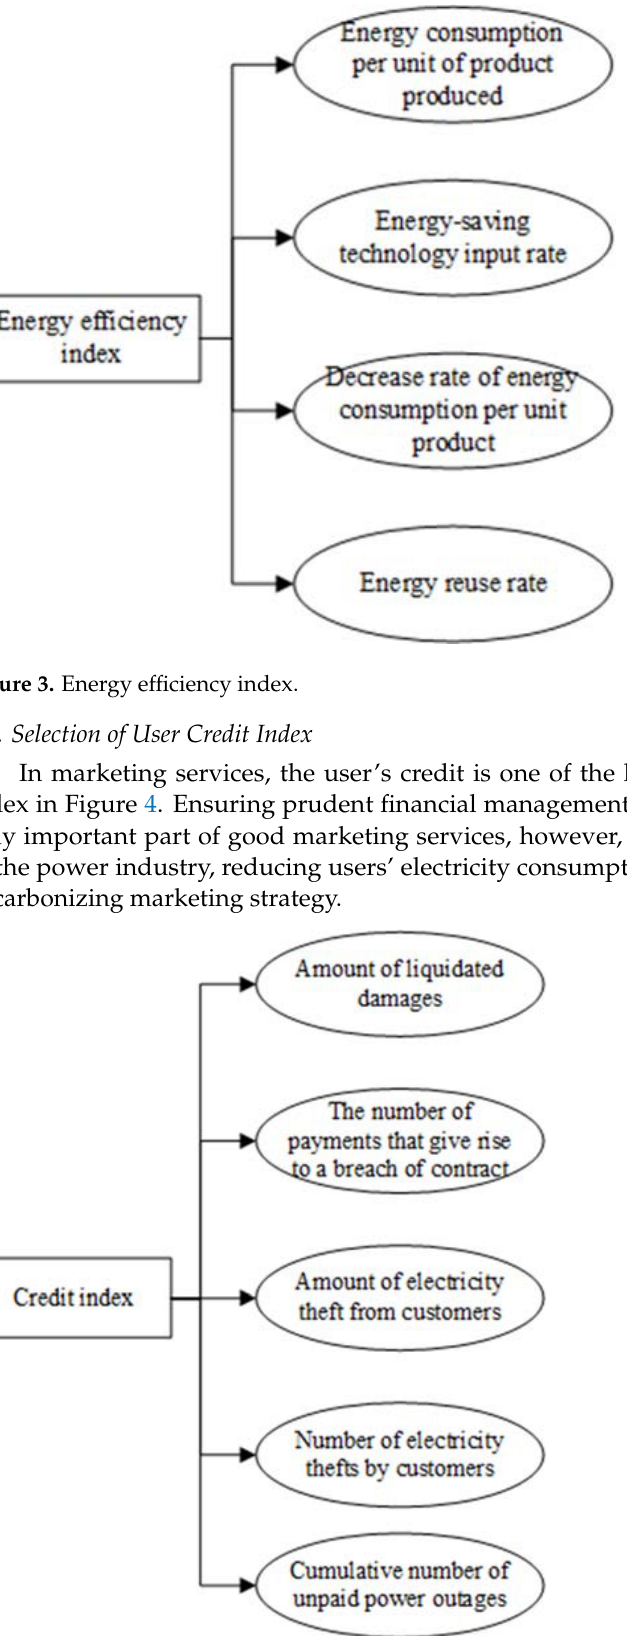
Figure 4. Credit index.